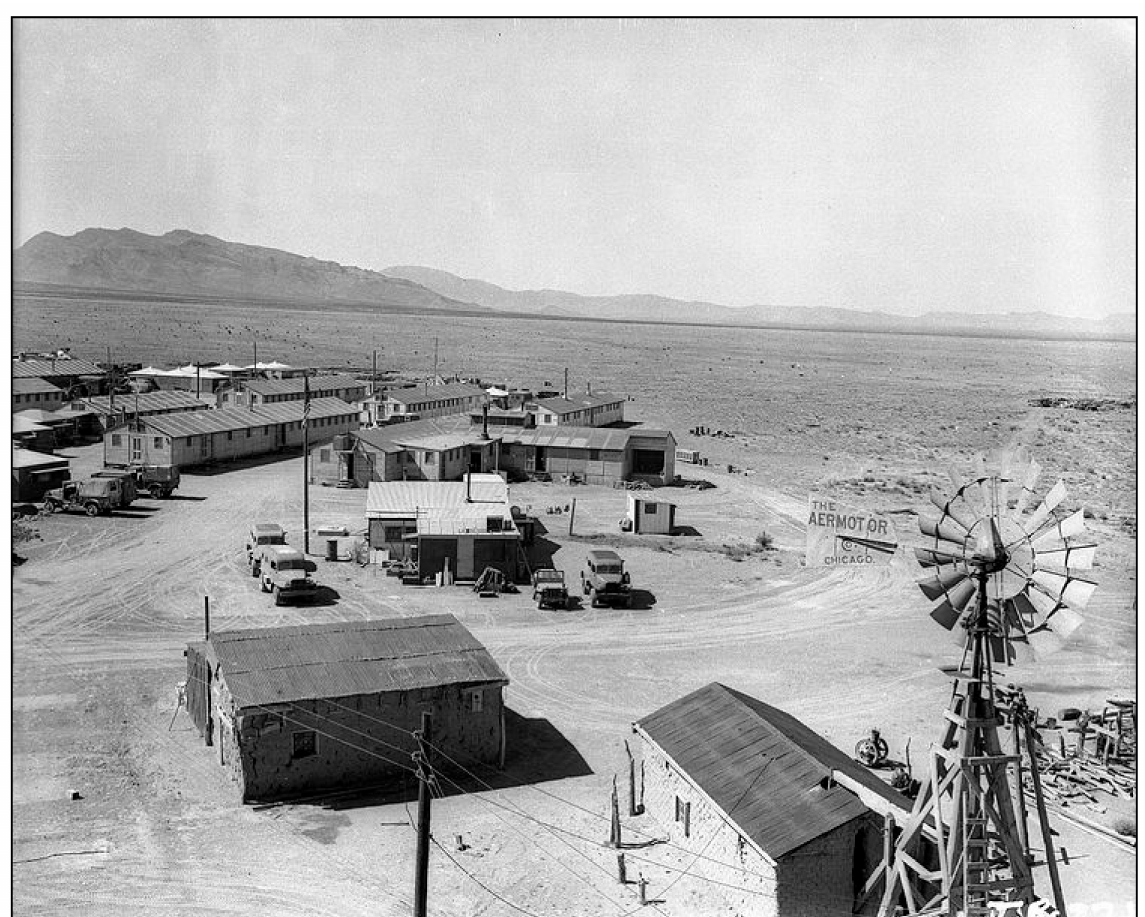
Figure 2. Trinity Test Base Camp, edge of Jornada del Muerto desert, New Mexico, May 1945. ( Wikicommons